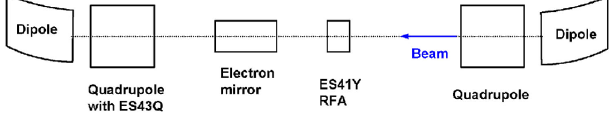
FIG. 12. (Color) Schematic layout (not to scale) of the section where electron cloud measurements (discussed in this paper) were made. The drift space between quadrupoles is 4.2 m and effective length of each quadrupole is 0.5 m.